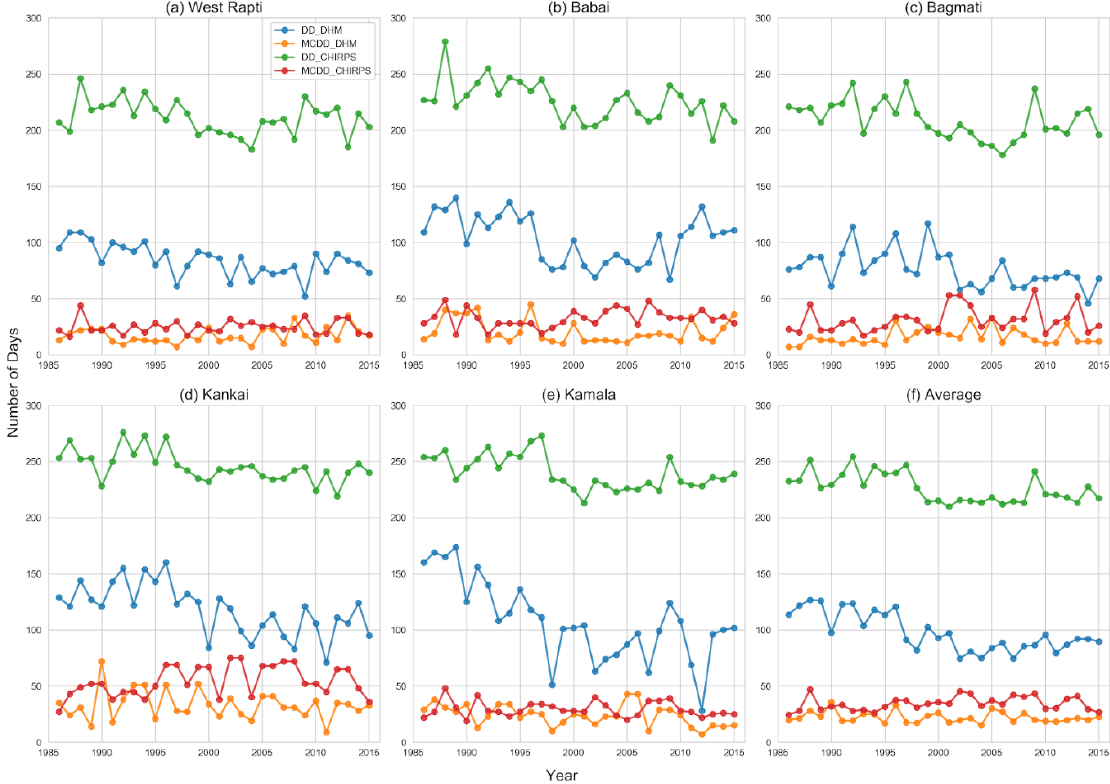
Figure 9. Line plots of temporal distribution (1986–2015) of dry days of DHM (DD_DHM: blue), dry days of CHIRPS (DD_CHIRPS: green), maximum consecutive dry days of DHM (MCDD_DHM: orange), and maximum consecutive dry days of CHIRPS (MCDD_CHIRPS: red) for ( a ) West Rapti basin, ( b ) Babai basin, ( c ) Bagmati basin, ( d ) Kankai basin, ( e ) Kamala basin, and ( f ) Average of all five basins.